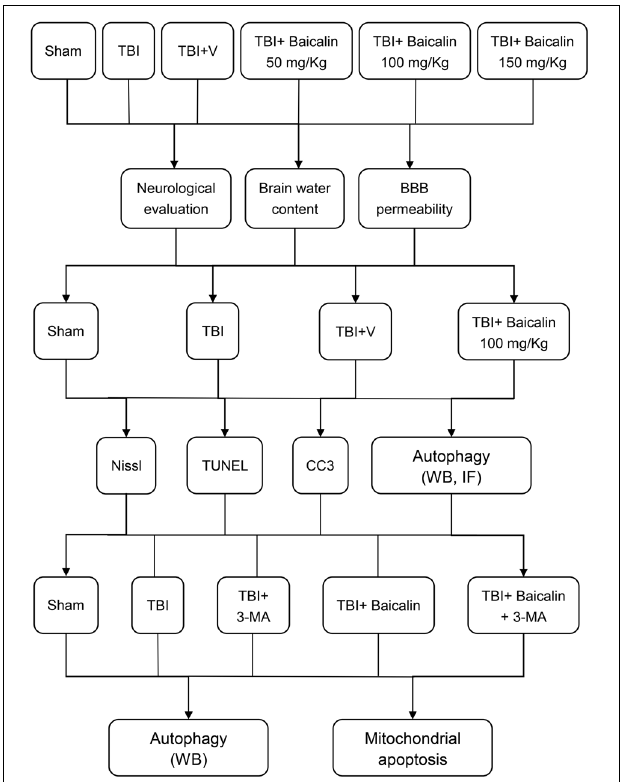
FIGURE 1 | The diagram demonstrating the experimental design throughout the